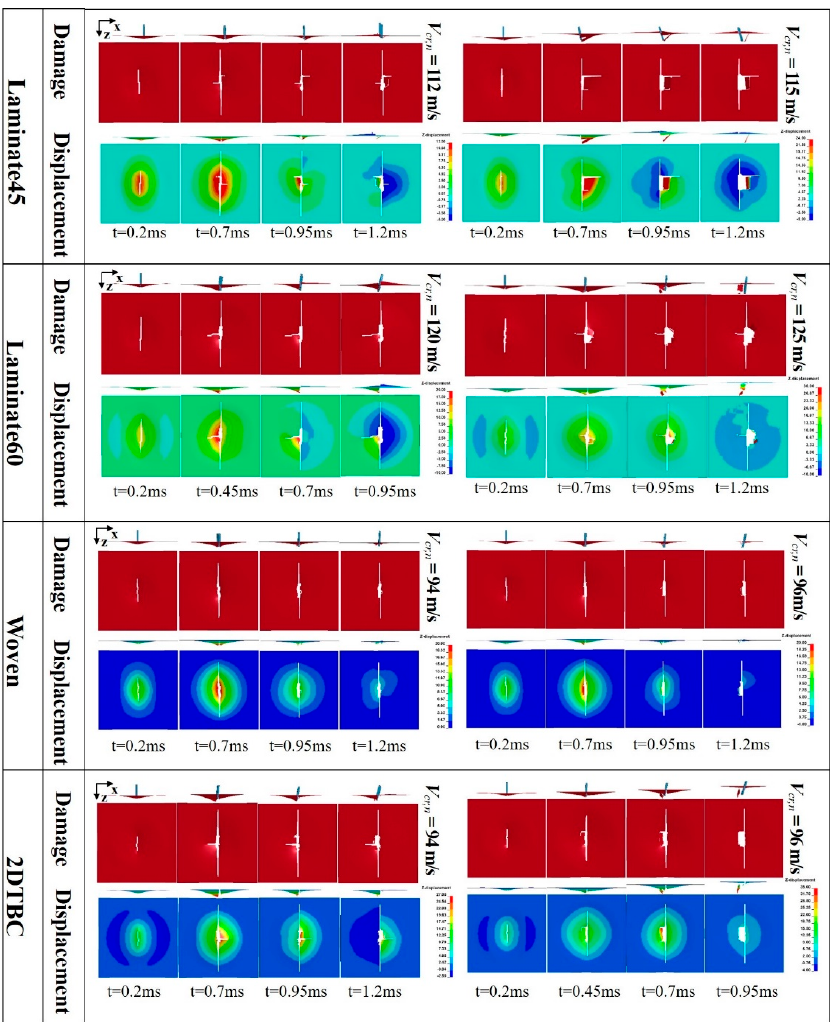
Figure 5. Numerical predicted impact damage patterns and displacement distributions for Laminate45, Laminate60, woven, and 2DTBC composite panels at different stages.